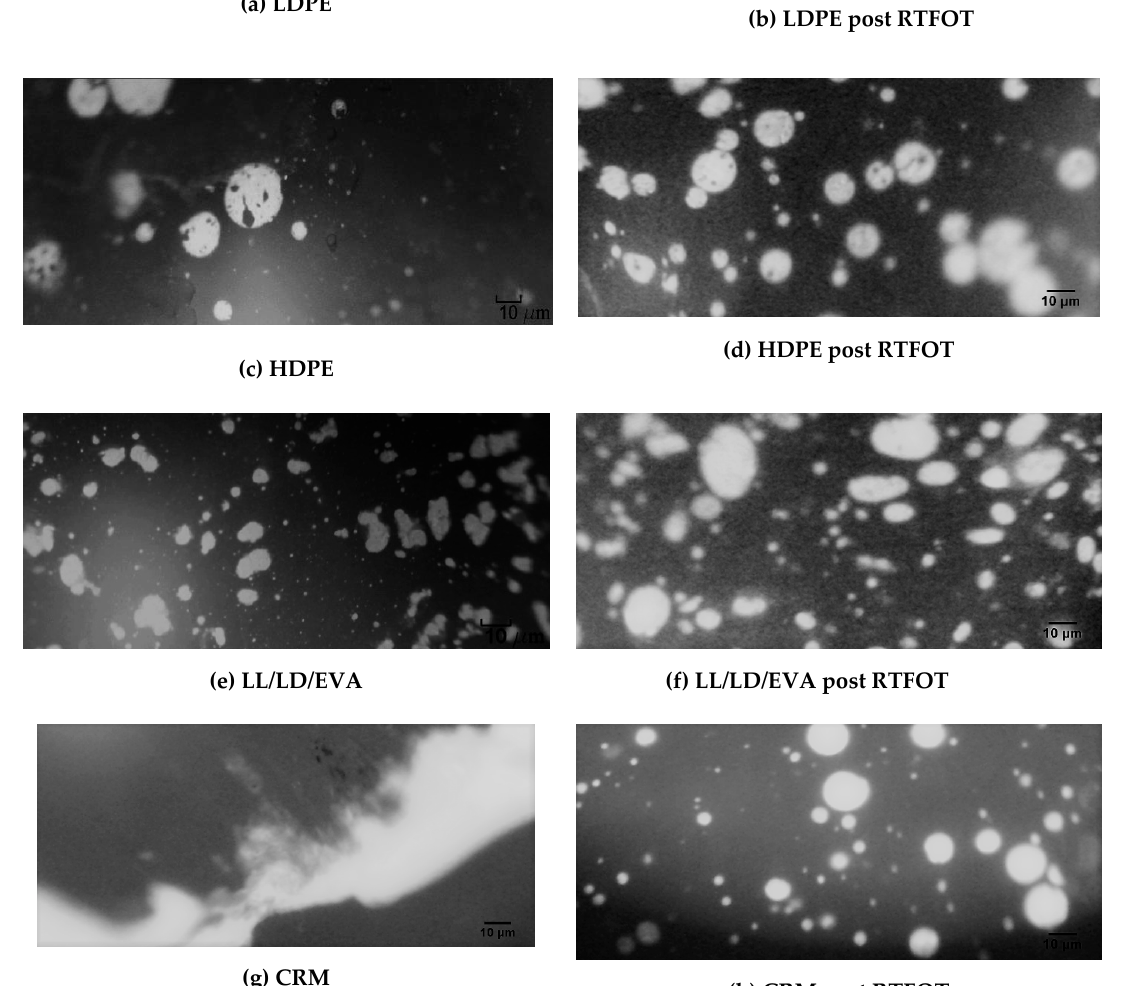
Figure 12. Micrographs of the PMBs produced, before and after short-term aging: ( a ) binder modified with LDPE before aging; ( b ) binder modified with LDPE after aging at the RTFOT; ( c ) binder modified with HDPE before aging; ( d ) binder modified with HDPE after aging at the RTFOT; ( e ) binder modified with LDPE-LLDPE-EVA before aging; ( f ) binder modified with LD/LL/EVA after aging at the RTFOT; ( g ) binder modified with CRM before aging; ( h ) binder modified with CRM after aging at the RTFOT.